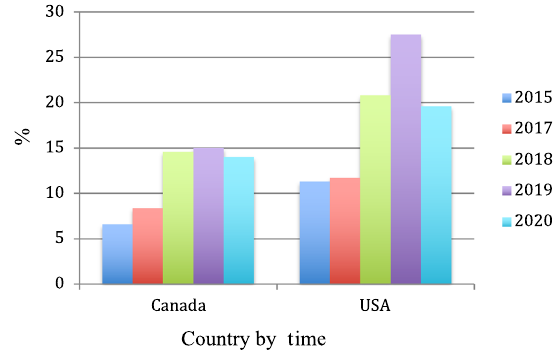
Fig. 3 Prevalence of e-cigarette use (past 30 days) in teenagers in North America over a fi ve year period (between 2015 and